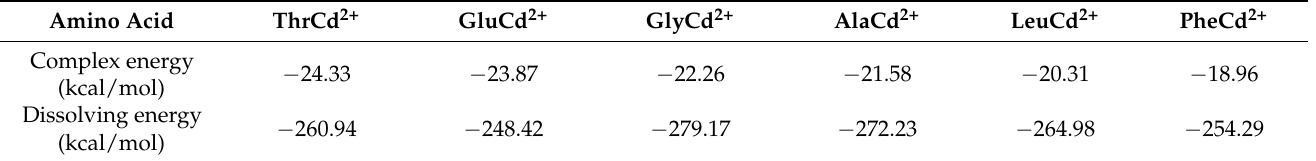
Table 4. Calculated energy of amino acids and cadmium